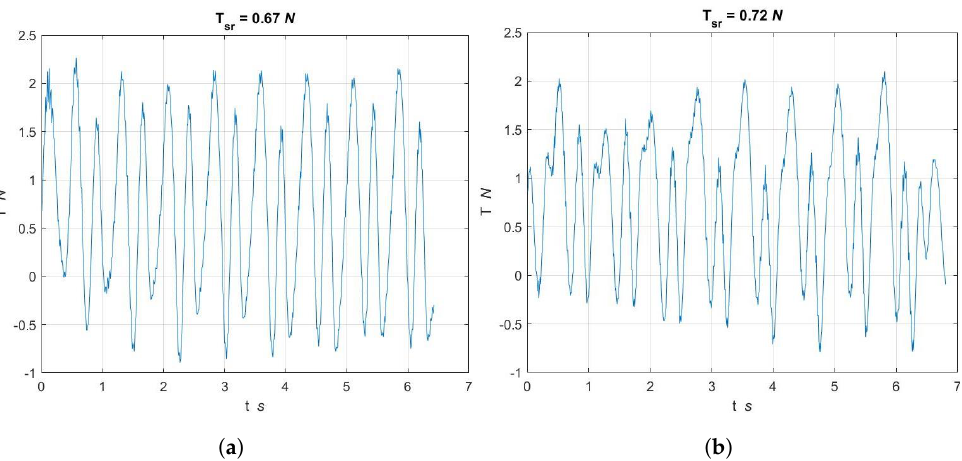
Figure 12. The thrust value as a function of time for fins dimensions: width 55 mm, thickness 0.75 mm and length: ( a ) 140 mm; ( b ) 290